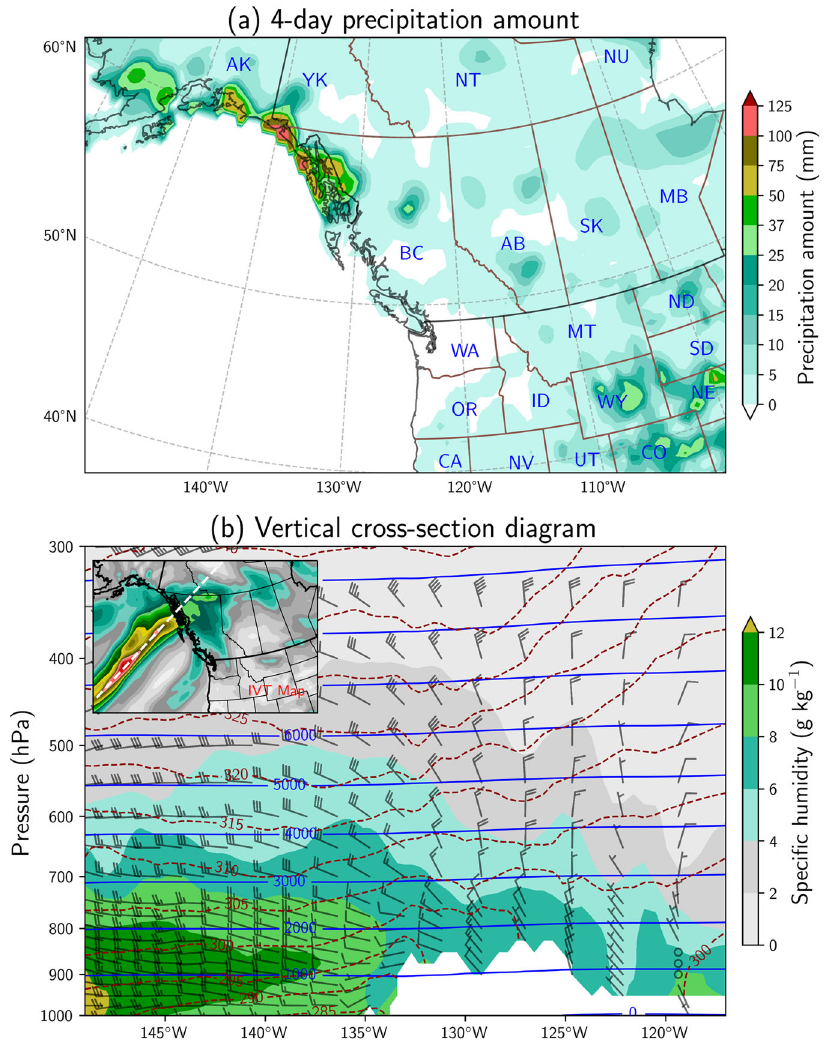
Fig. 4 The precipitation distribution and the atmospheric river pro fi le. a The 4-day precipitation amount during 24 – 27 June 2021 (see “ Methods ” for data description); the 96 h period ends at 0600 UTC in Canada and at 1200 UTC 27 June in the United States. b An along-AR vertical cross section (along the white line in the embedded box) valid at 0000 UTC 25 June 2021 based on the ERA5 reanalysis; colour- fi lled contours represent the speci fi c humidity, red dashed lines are potential temperature contours (unit: K, intervals: 5 K), blue solid lines are elevations above sea level (unit: m, intervals: 1000 m), and winds are indicated by the conventional wind